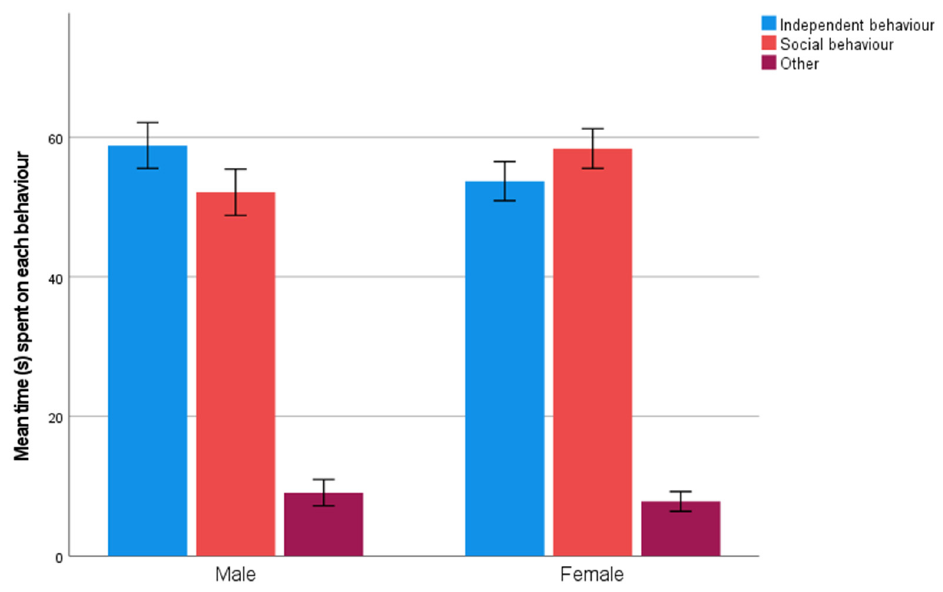
Figure 5. Mean time (s) spent on each behavioral strategy (independent, social, or abandoning the task) for males ( n = 468) and females ( n = 539) during the unsolvable task (95% confidence